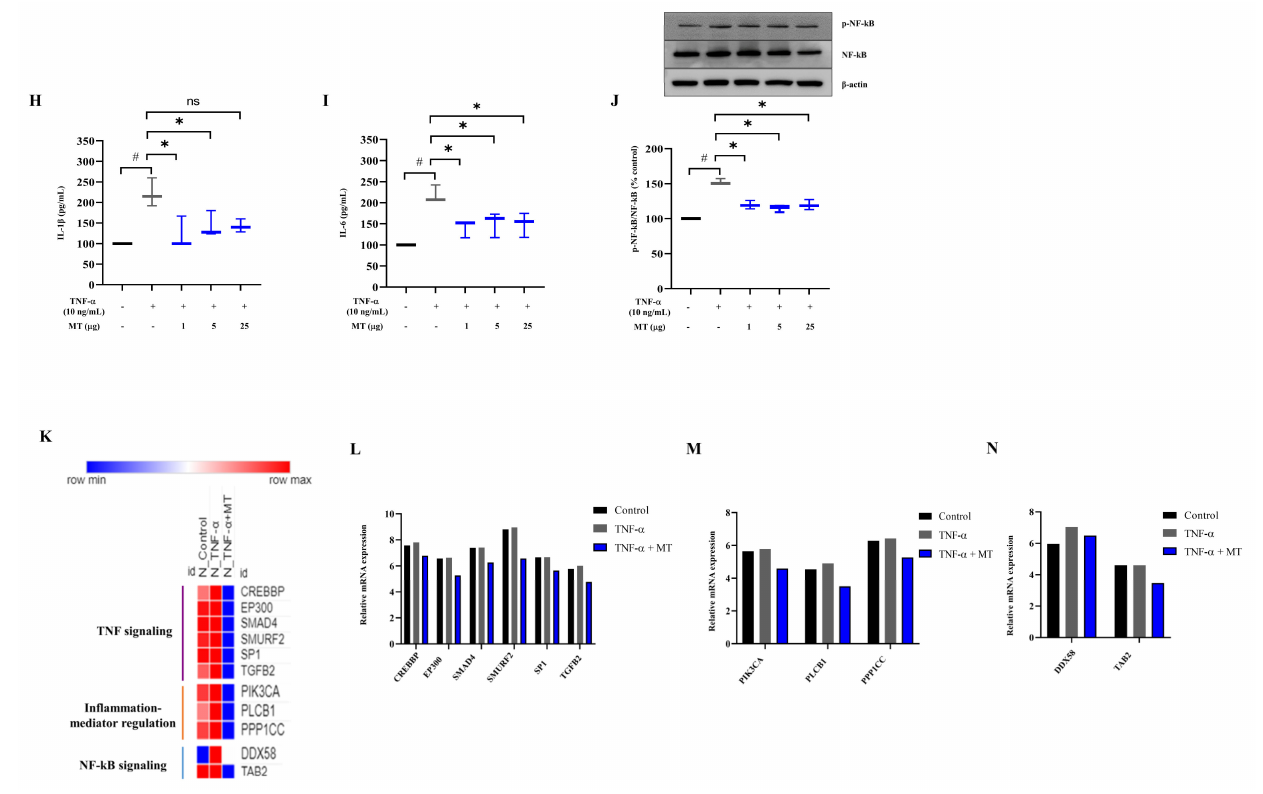
Figure 3. Effect of mitochondrial transplantation on mitochondrial dynamics and apoptosis- and inflammation-related marker levels in TNF α -treated tenocytes in vitro. ( A – G ) Effect on mitochondrial dynamics and apoptosis: ( A – C ) changes in levels of mitochondrial fission markers, such as Fis1 and Drp1 and the fusion marker MFN2. Representative western blots and densitometric quantification of ( A ) Fis1, ( B ) Drp1, and ( C ) MFN2. ( D – G ) Impact on apoptosis-related markers BID, Bax, Bcl-2, and cleaved caspase 3. Representative western blots and densitometric quantification of ( D ) BID, ( E ) Bax, ( F ) Bcl-2, and ( G ) cleaved caspase 3. ( H – N ) Effect on inflammation-related markers: ( H , I ) show that mitochondrial transplantation decreased the levels of inflammatory markers, such as ( H ) IL-1 β and ( I ) IL-6, as determined using ELISA. Representative western blot and densitometric quantification of ( J ) NF- κ B signaling. ( A – G ), ( J ): β -actin as a loading control. Data represent mean ± standard deviation (SD) ( n = 3). # p < 0.05 between TNF- α (+) group (black) and TNF- α ( − ) group as control (white), * p < 0.05 between MT (+) group damaged by TNF- α (gray) and MT ( − ) group damaged by TNF- α (black); ( K ) microarray profiling (heat map and hierarchical clustering of differential expression of mRNAs) shows the gene pathways of TNF signaling, inflammation, and NF- κ B signaling altered by mitochondrial transplantation in MT (+) group damaged by TNF- α (N_TNF- α + MT) and MT ( − ) group damaged by TNF- α (N_TNF- α ). Blue color in N_TNF- α + MT indicates reduced TNF signaling levels, inflammation mediator regulation, and NF- κ B signaling after MT transplantation. The color scale at the top illustrates the relative expression level of mRNA across all samples; ( L – N ) shows the relative expressions of mRNA regarding ( L ) TNF, ( M ) inflammation, and ( N ) NF- κ B signaling pathways among three groups such as TNF- α with MT, TNF- α without MT, and control. TNF- α , tumor necrosis factor- α ; MT, mitochondria; Fis1, Fission 1; Drp1,